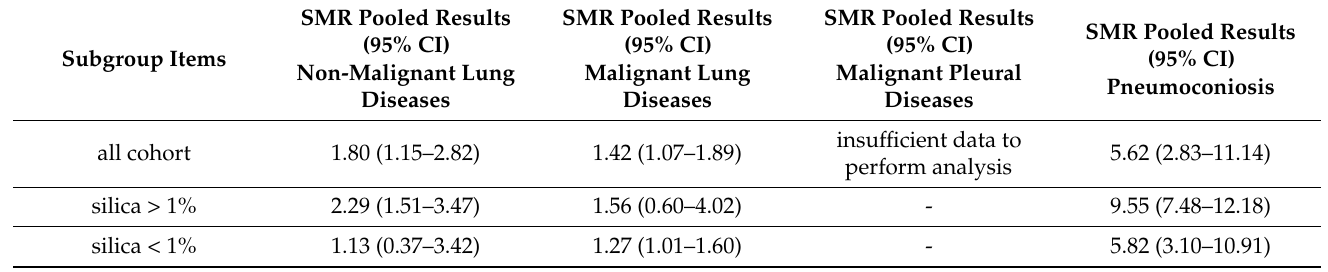
Table 4. SMR pooled results for malignant and non-malignant respiratory diseases.